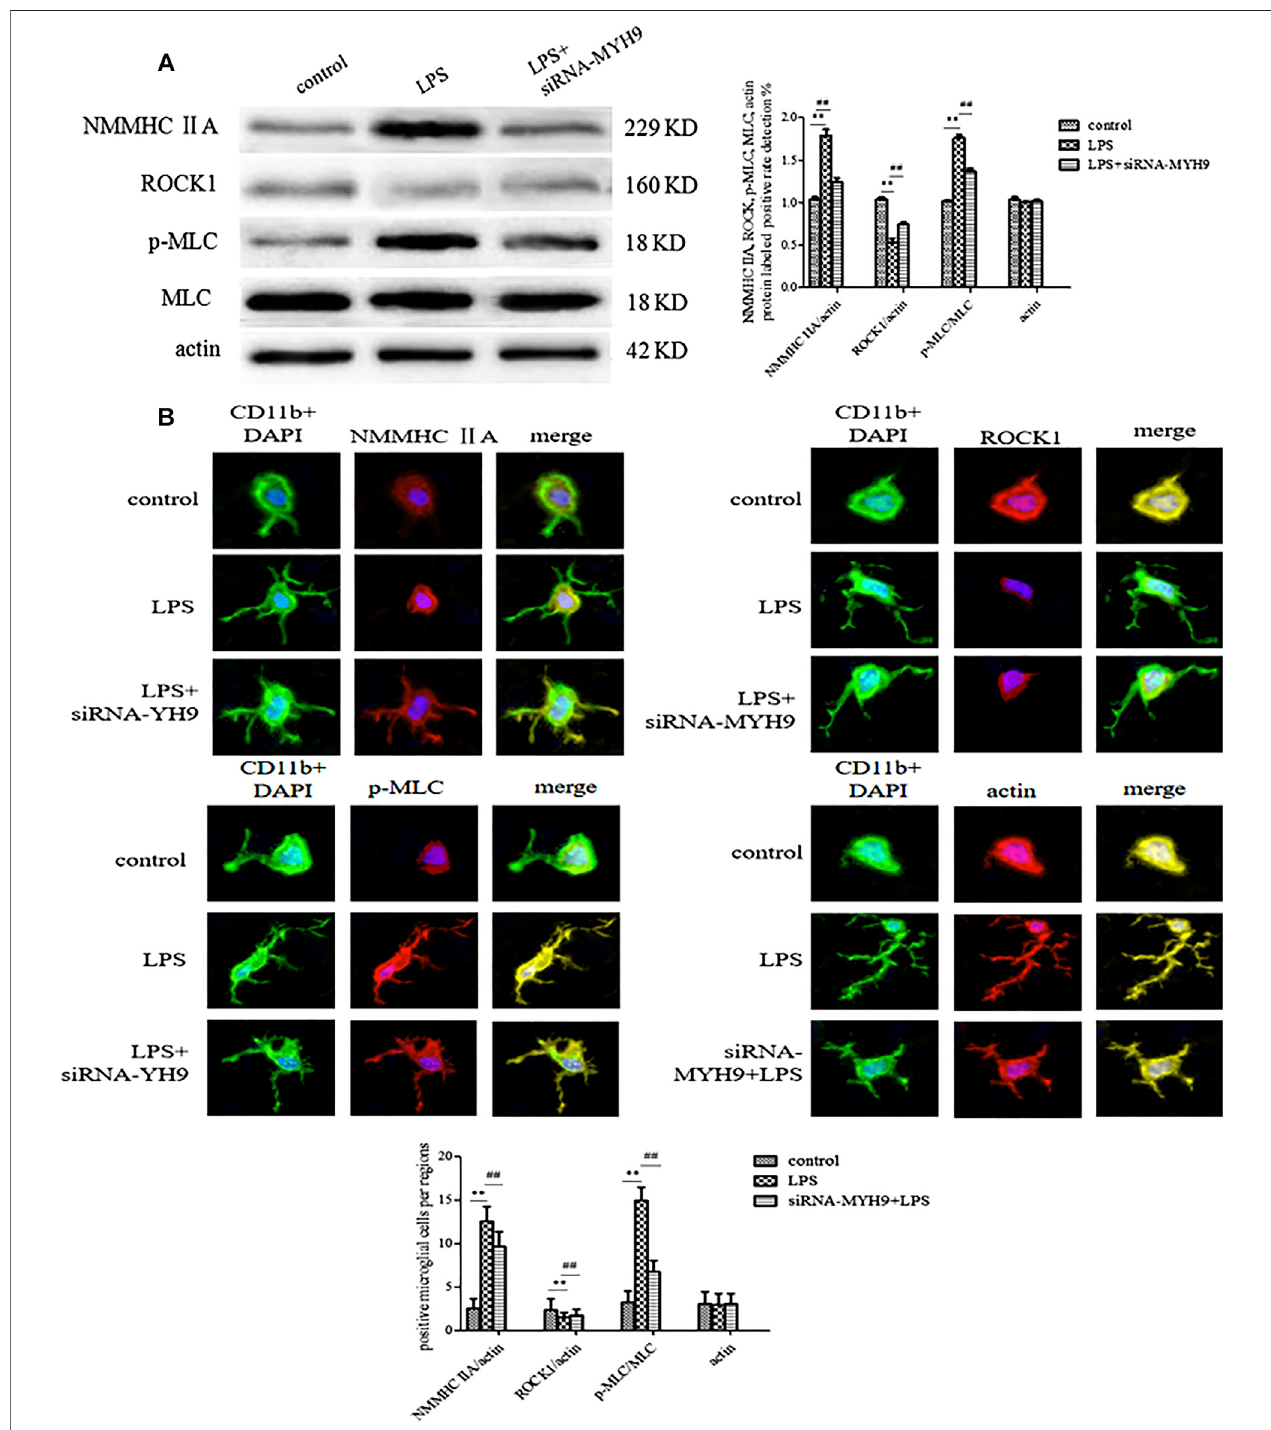
FIGURE 6 | The NMMHC Ⅱ A-regulated ROCK1/MLC/actin pathway might be the potential mechanism for exosome release. The exosomes were divided on the basisofwhethertheywereextractedfromcontrolmicroglialcells,microglialcellsincubatedwith1 mg/mlLPSfor24 h,andmicroglialcellstransfectedwithsiRNA-MYH9 at a fi nal concentration of 100 nM for 48 h. (A) Microglial cells were immuno fl uorescently stained with anti-NMMHC Ⅱ A, anti-ROCK1, anti-MLC, or anti-actin, together with CD11b (green) and DAPI for nuclei (blue). Stained cells were examined by confocal microscopy. Scale bars (cid:2) 10 μ m. A histogram depicted the quantitative fl uorescence intensity from fi ve vision fi elds from nine independent experiments for each group of microglial cells. (B) The protein expression levels of anti-NMMHC Ⅱ A, anti-ROCK1, anti-MLC, and anti-actin were examined by western blotting. Western blots were quanti fi ed. A histogram depicted the quantitative representations of the proteinexpressionlevelsofNMMHC Ⅱ A,ROCK1,MLC,andactinforeachgroup.Nineindependentexperimentswereanalyzed.ThedatawereaverageswithSD, n (cid:2) 9. ** p < 0.01 vs. control microglial cells; ## p < 0.01 vs. microglial cells cultured for 24 h.